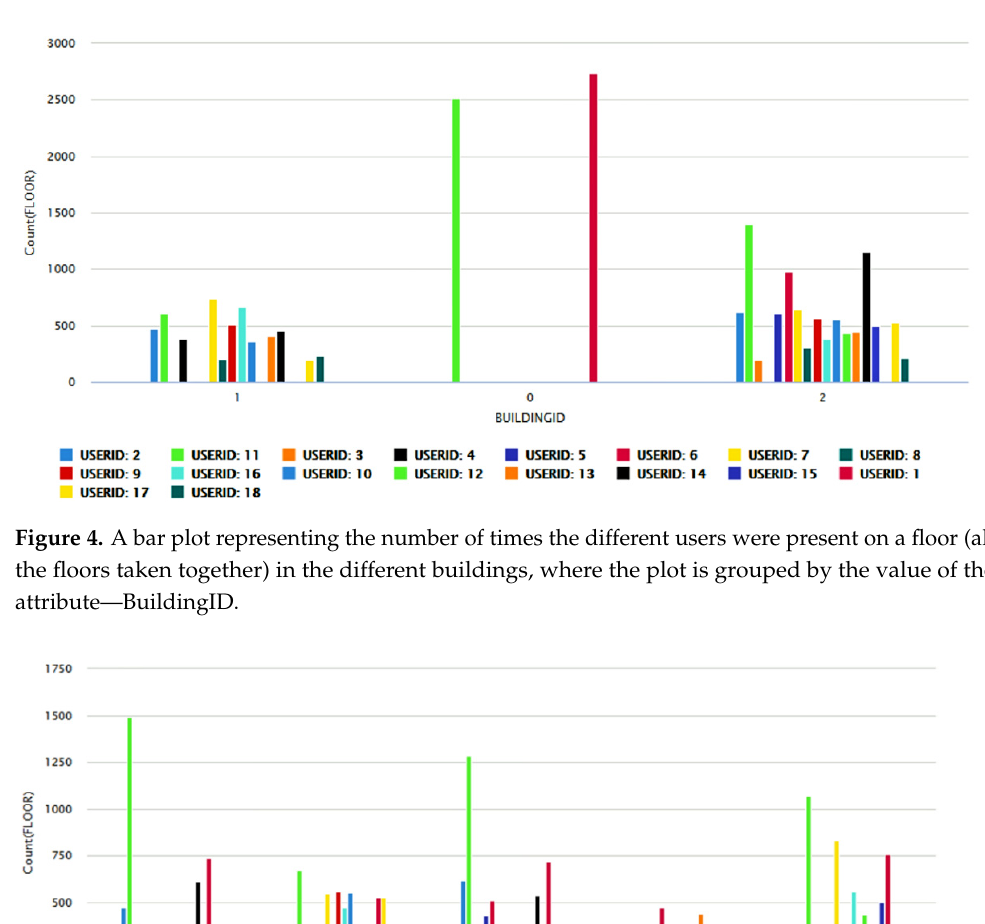
Figure 6. A bar plot representing the number of times the different users were present in different spatial regions (not all of them are shown to maintain clarity) in different buildings, where the plot is grouped by the value of the attribute—SpaceID. Figure 7. A bar plot representing the number of times the different users were either inside or out- side a spatial region across the different floors in the different buildings, where the plot is grouped by the value of the attribute—RelativePosition.